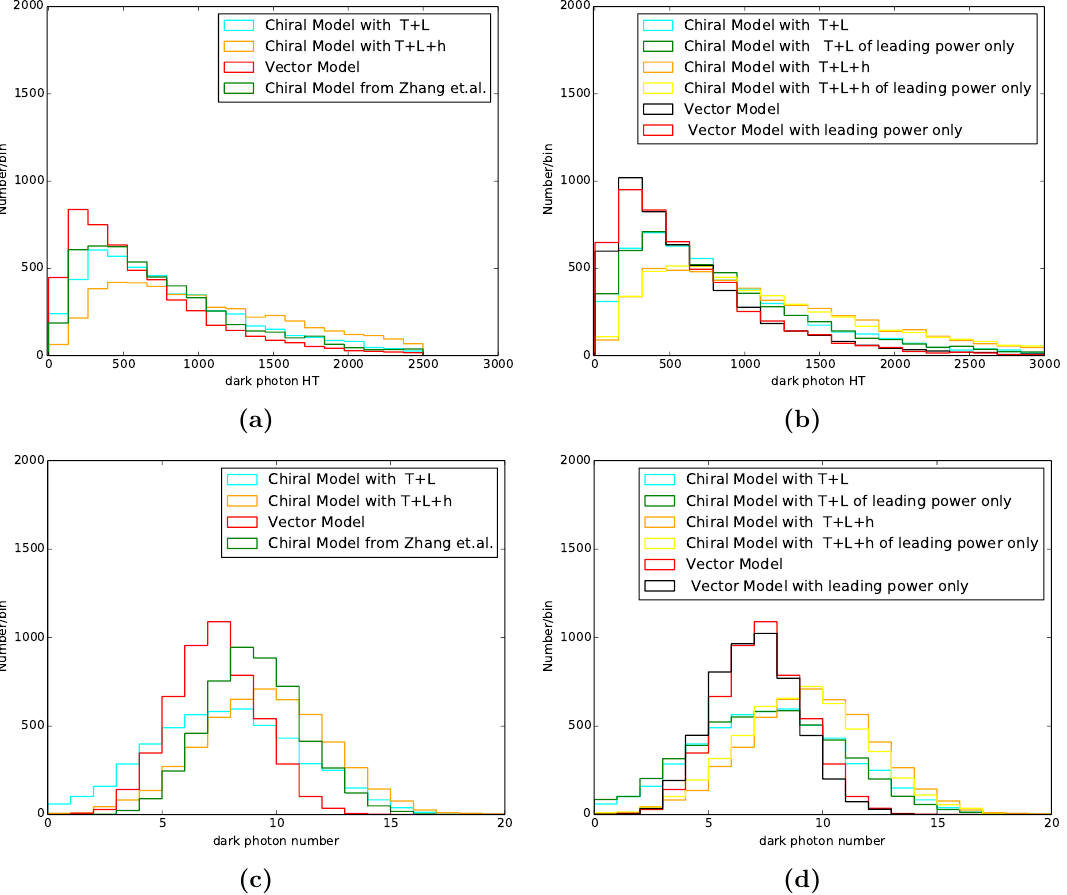
Figure 2 . Dark shower with Point A: (cid:11) 0 = 0 : 3, m (cid:31) = 0 : 7 GeV, m A 0 = 0 : 4 GeV, and m h 0 = 1 : 0 GeV. \T", \L", \h" represent the types of splitting functions: \T" for (cid:31) s ; \h" for (cid:31) s (cid:31) s (cid:31) s 0 A 0 (cid:31) s 0 h 0 . \Leading power" denotes the splitting functions with leading L ! ! 1 power contributions, i.e. those scaling as d P . \Zhang et al." labels the splitting functions dzdk 2 T (cid:24) k 2 T from [15] by Zhang et